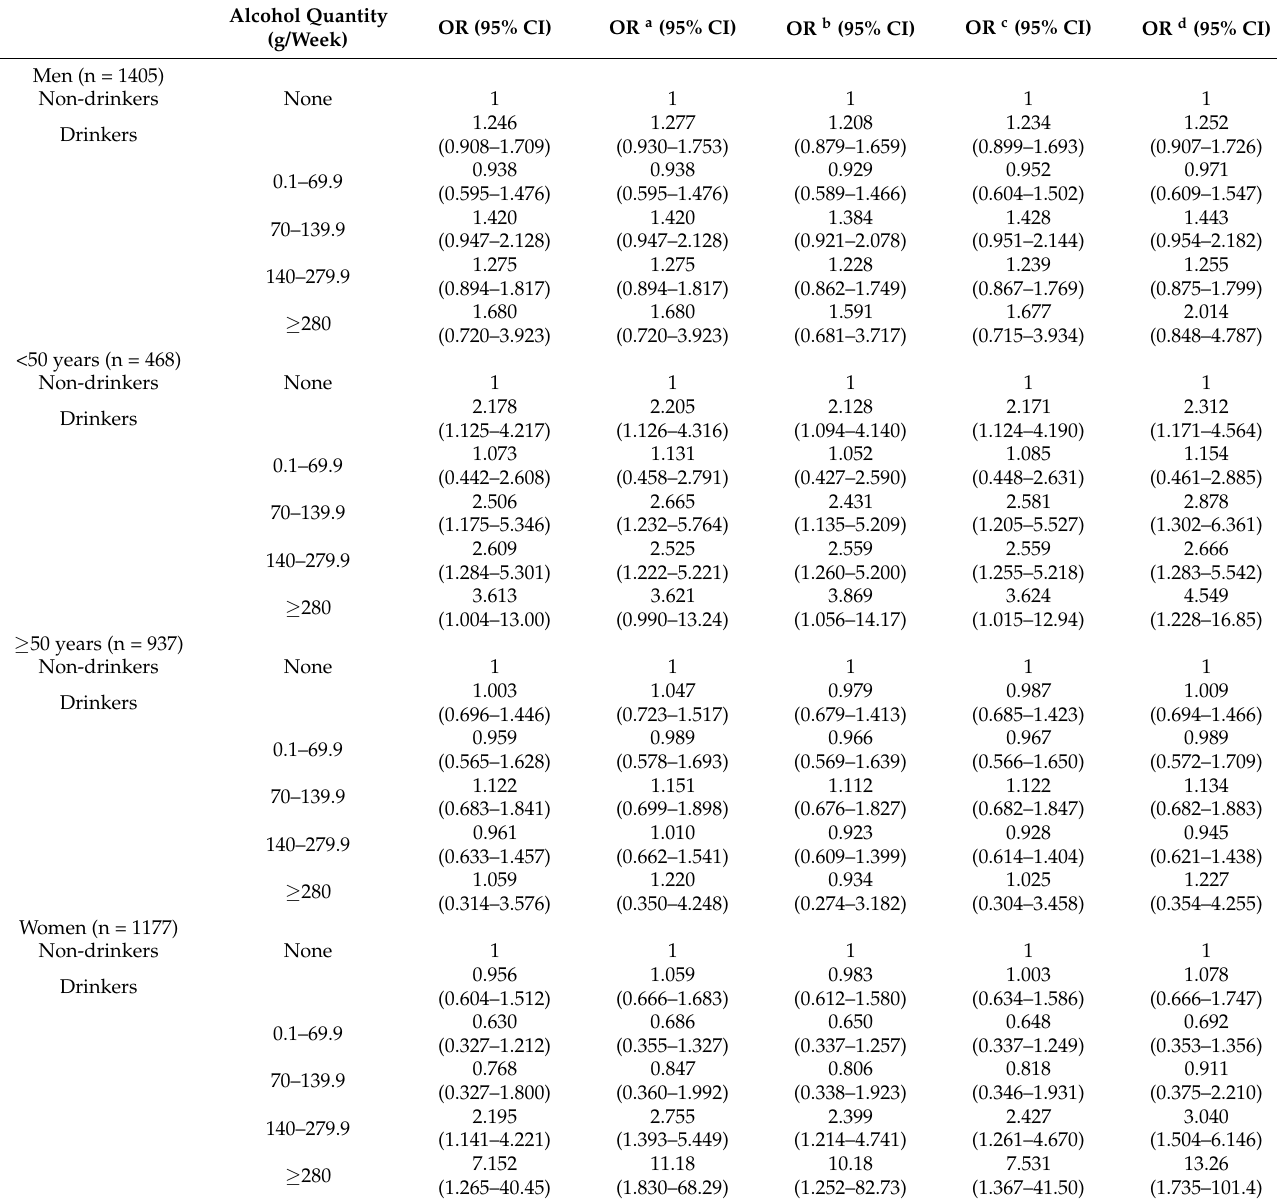
Table 5. Relationship between EE development and alcohol quantity according to